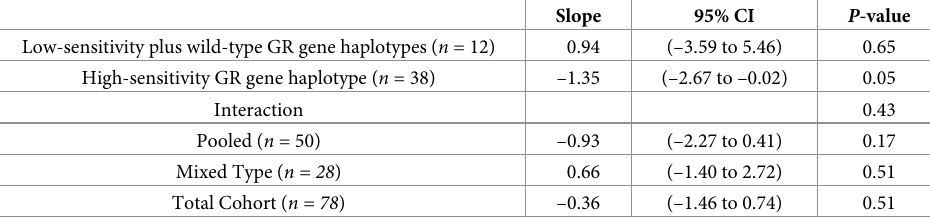
Table 5. The relationship between daily ICS dose and adrenal suppression assessed by linear regression.